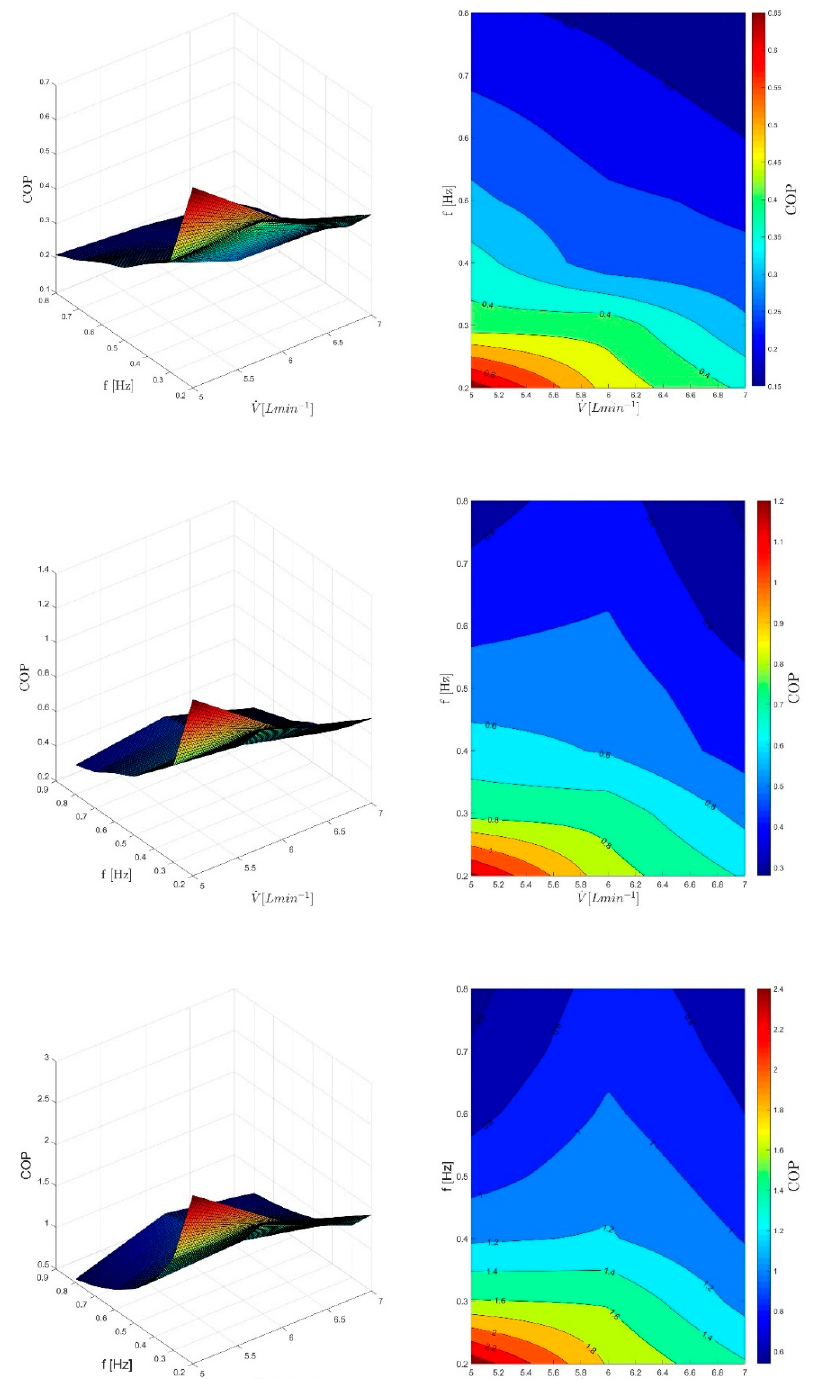
Figure 15. COP of ‘8MAG’ as a function of volumetric flow rate and operating frequency at T H = 22 °C and different cooling power (50 W, 100 W, and 200 W, from the top to the bottom). Temperature spans are in the range between 1 K and 8.5 K.